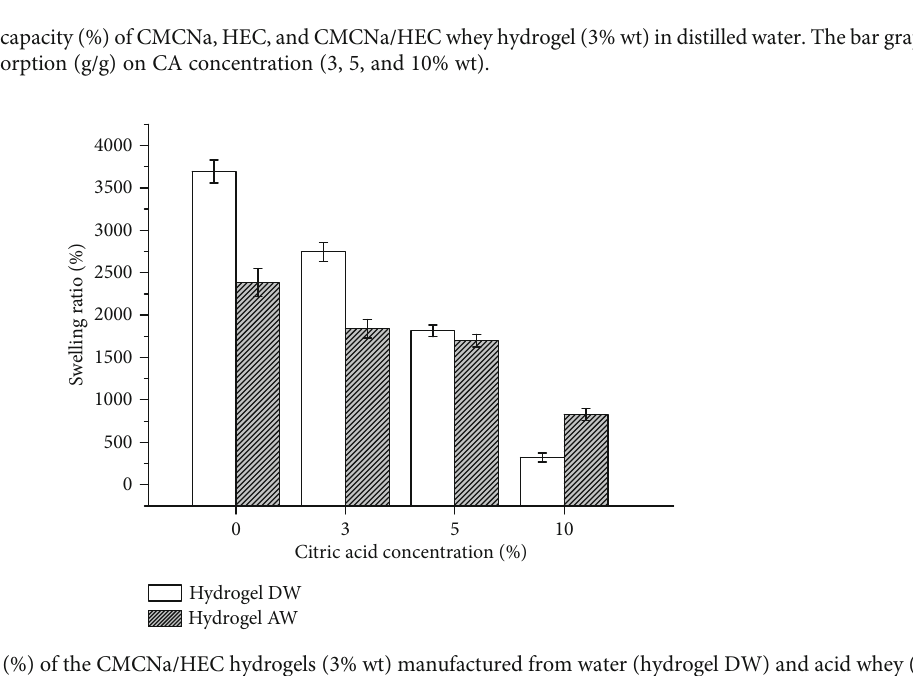
Figure 2: The swelling ratio (%) of the CMCNa/HEC hydrogels (3% wt) manufactured from water (hydrogel DW) and acid whey (hydrogel AW), cross-linked by di ff erent concentrations of